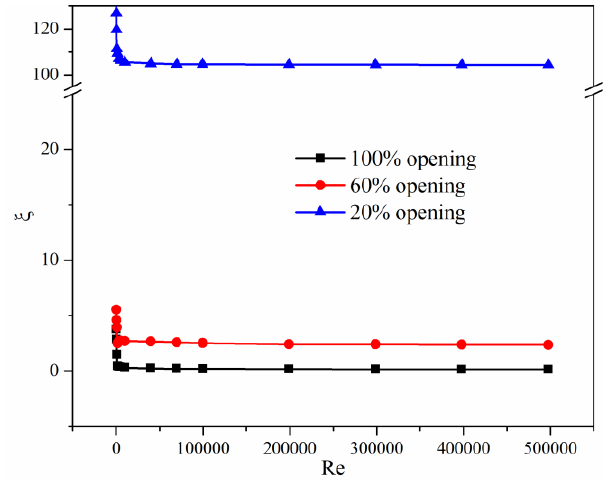
Figure 10. Loss coe ffi cients under di ff erent valve opening degree and Reynolds Figure 10. Loss coefficients under different valve opening degree and Reynolds number.